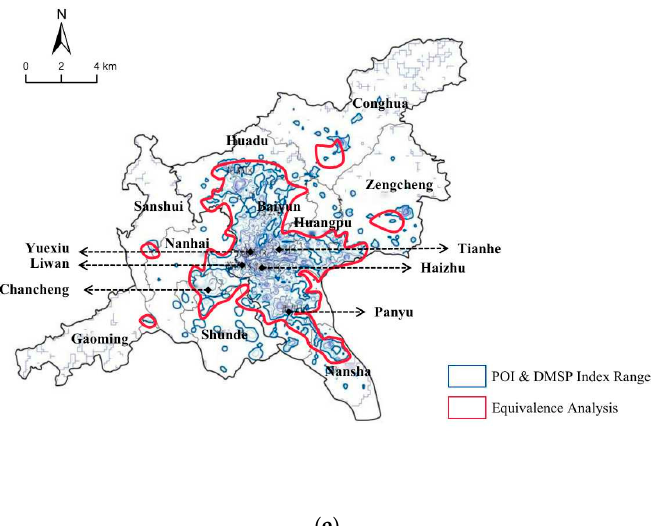
Figure 3. Identification results of the geographic scope of Guangzhou-Foshan core entities. ( a ) POI density analysis; ( b ) night light index analysis; ( c ) DMSP and POI index synthesis; ( d ) equivalence analysis; ( e ) the core entities of Guangzhou-Foshan.